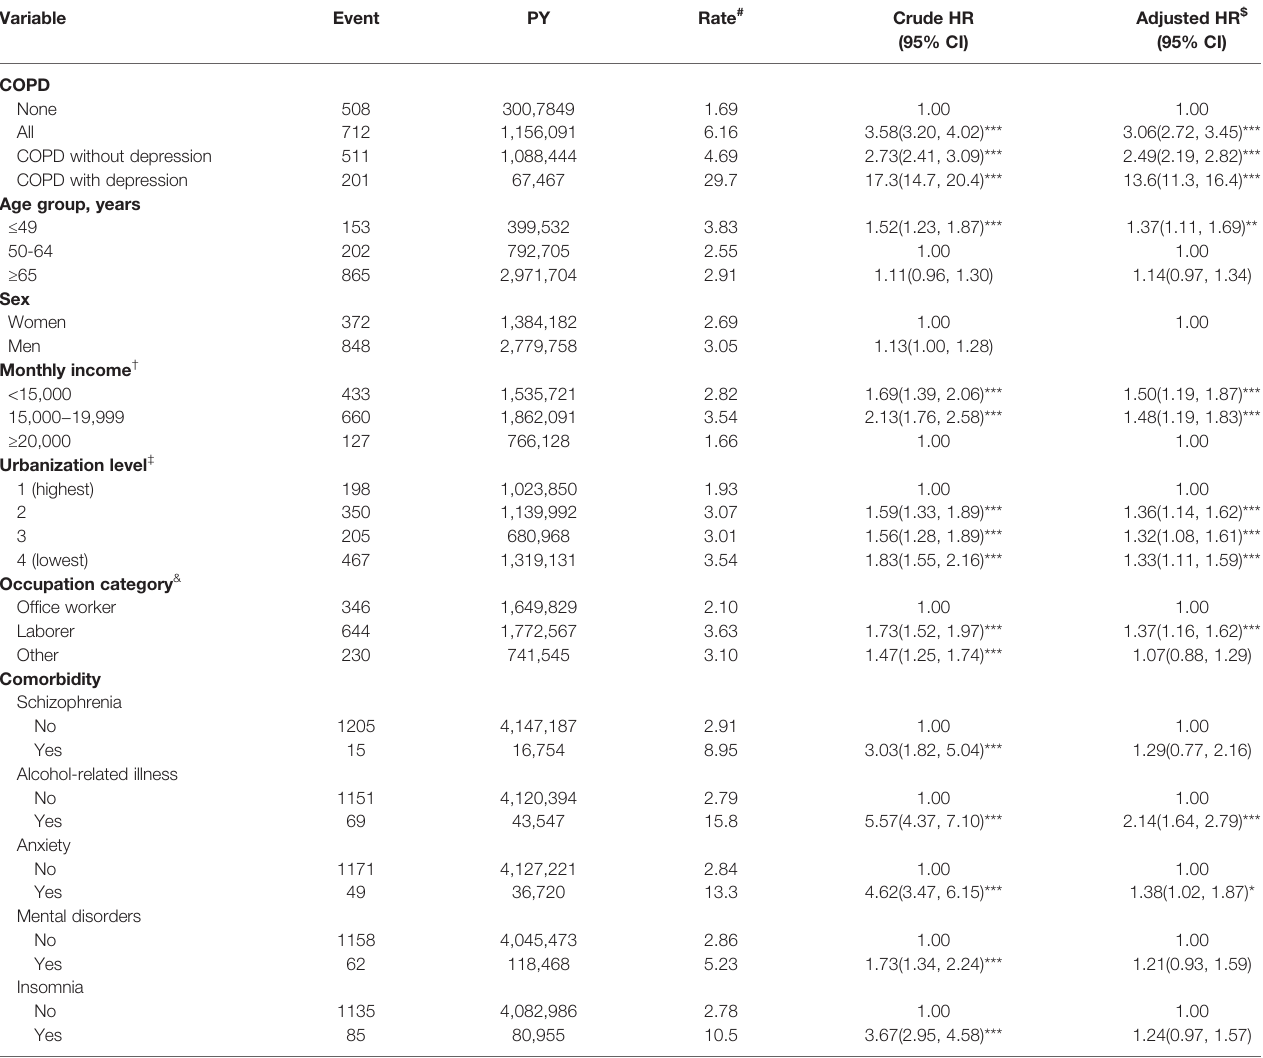
TABLE 2 | Incidence and risk factors for suicide attempt across different